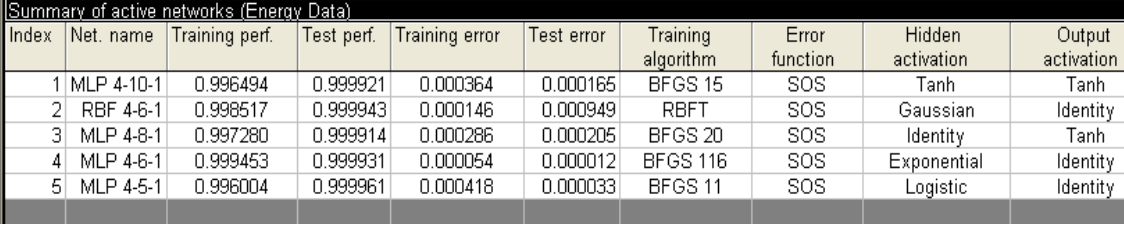
Figure 5. The ANN analysis results.